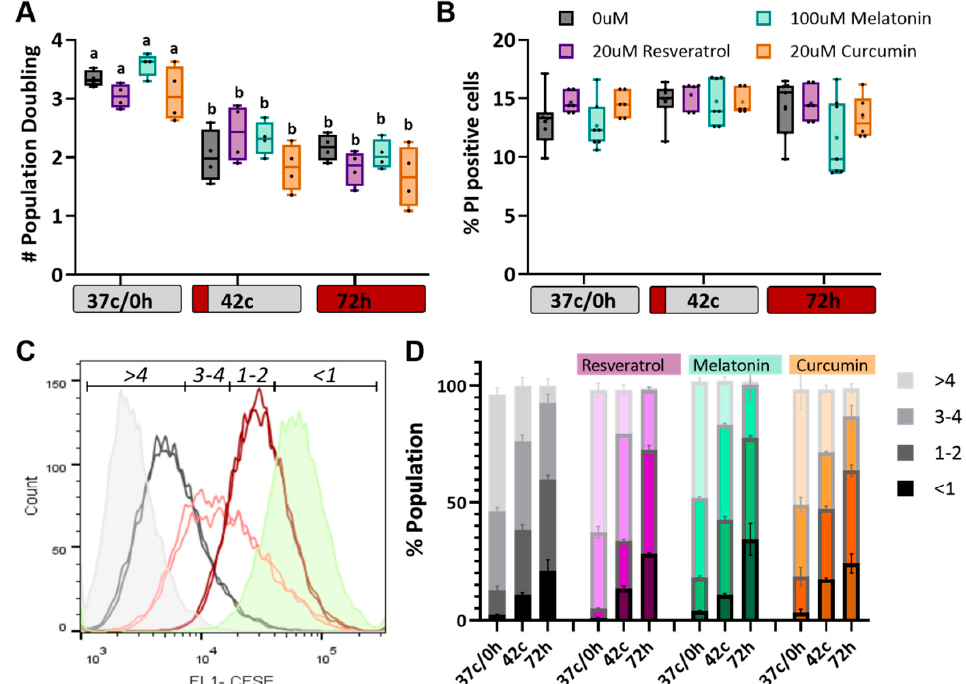
Figure 3. The effect of resveratrol, curcumin, and melatonin on the viability and proliferation of MSC. ( A ) Population doubling time was calculated after 5 days in culture. n = 4. Two-way ANOVA with multiple comparisons test FDR rates calculated using two-stage linear step-up procedure of Benjamini, Krieger and Yekutieli was used for statistical analysis, different letters indicate significant differences ( p < 0.05). ( B ) Propidium iodide staining on unfixed cells was performed to quantify the number of dead cells in the population following heat shock and/or antioxidant treatments. n = 6. No significant difference was found. ( C ) CFSE staining in cells before and after short or long heat shock treatment (black and pink and red, respectively) is shown. Undivided cells are used as a positive control (green) and unstained cells as a negative (black). The gates used for further analysis are shown. ( D ) Mean percentage of cells in each state are shown, n = 6. No significant difference detected as measured by Two-way